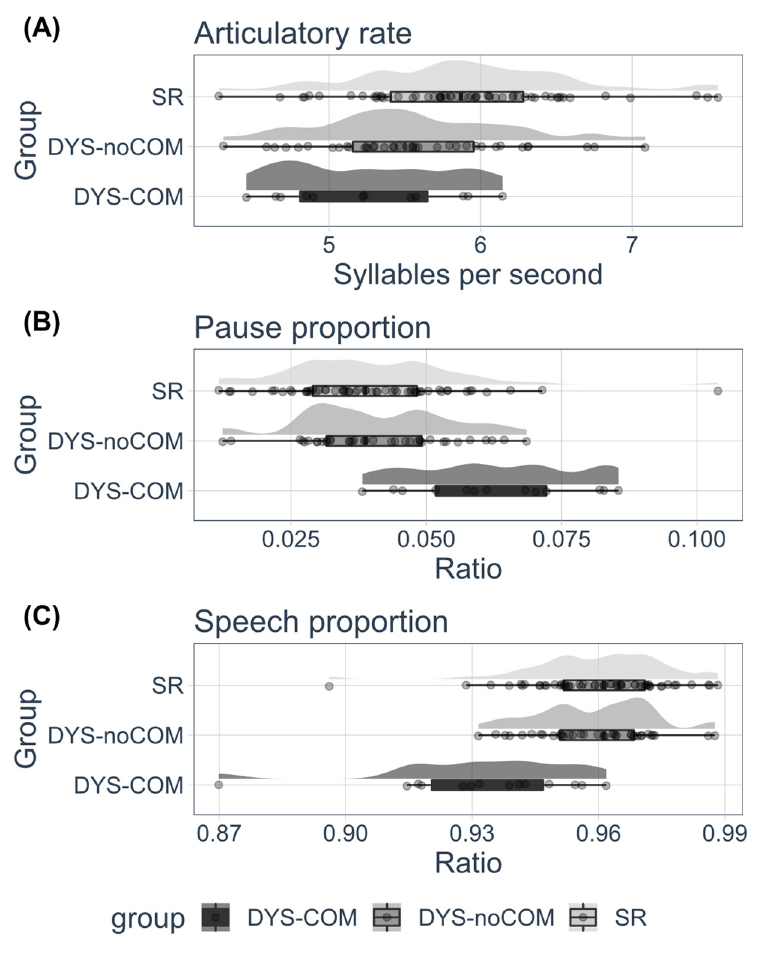
Figure 2. Articulatory evaluation: raincloud plots with distribution of raw data, probability density, and summary statistics (i.e., boxplot with median, interquartile ranges and confidence interval) of ( A ) “Articulatory rate”, ( B ) “Pause proportion”, ( C ) “Speech proportion” for the three groups of participants (DYS-noCoM: Dyslexic readers with no motor impairment, DYS-CoM: Dyslexic readers with motor impairment, SR: Skilled readers control